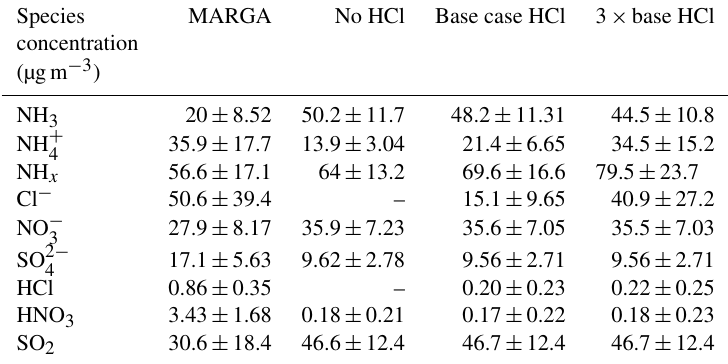
Table 2. Daily mean ± 1 σ in gases and inorganic aerosol concentration observed (MARGA) and simulated in sensitivity test with